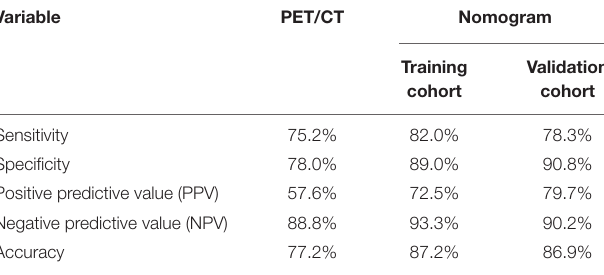
FIGURE 3 | Decision curve analysis for the nomogram.